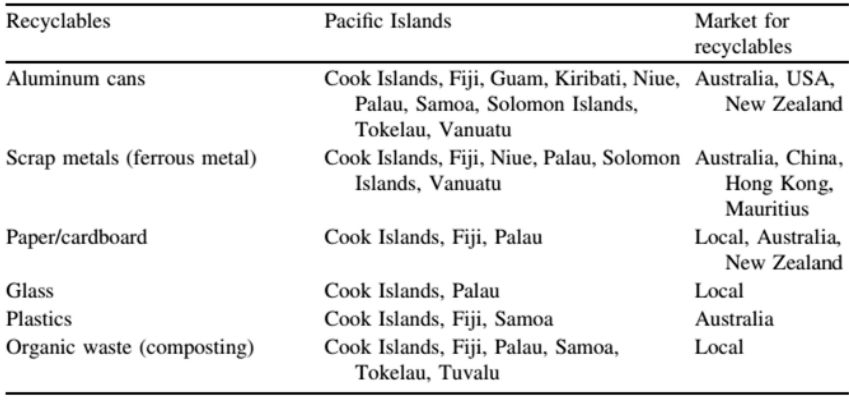
Source : Pariatamby & Tanaka, 2013, p.